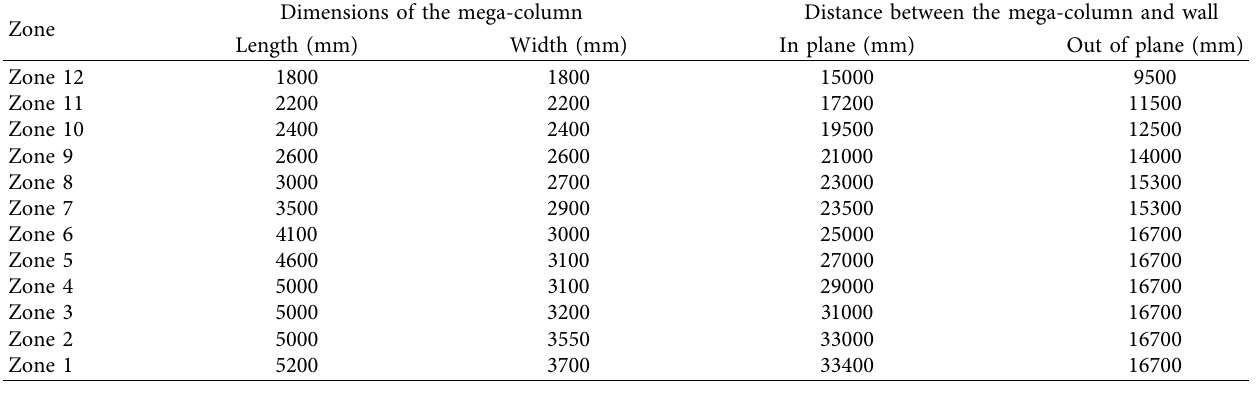
Table 8: Prototype mega-column.